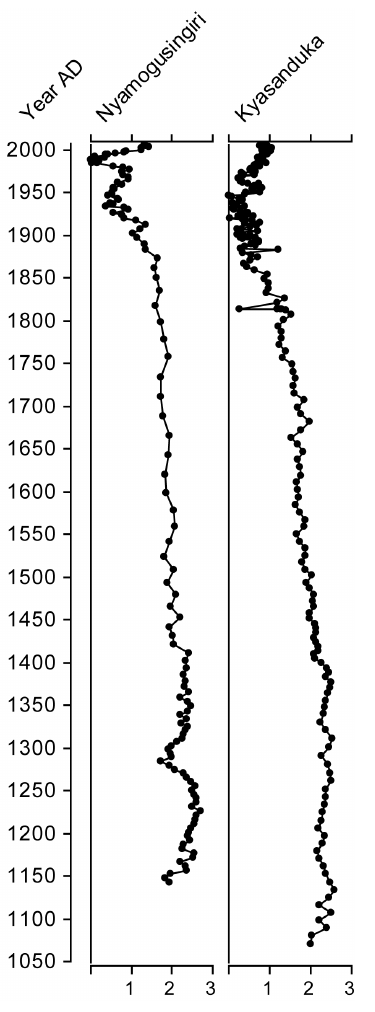
Figure 7. Comparison of DCA axis 1 sample scores from Lake Nyamogusingiri and Lake